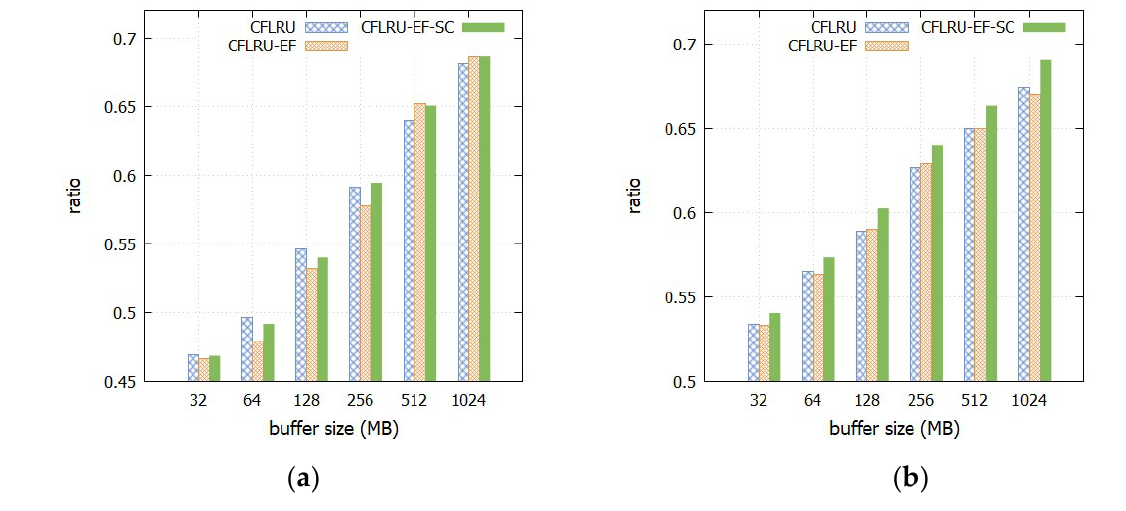
( d ) Figure 7. Cache hit ratio. ( a ) camresweba03-lvm01; ( b ) prn0; ( c ) proj0; ( d ) prxy0. 4.3. Results in an Environment with Periodic Flushing When using volatile memory, such as DRAM, as the internal buffer of an SSD, dirty buffers must be forcibly flushed to NAND upon request from the operating system or application programs. Since dirty buffers are frequently switched to clean buffers by the forced flush, the effect of early flushing is expected to decrease. In this section, we present the performance evaluation results of the CFLRU-EF-SC policy in an environment where forced flushing is performed every 30 s. Since the evaluation results between traces were similar, we present only the results for the hm0prn0proj0prxy0 trace. The results show the following. First, as shown in Figure 8a, the early flush is effec- tive in reducing the average response time even in the environment where periodic forced flushing is performed. The improvement is particularly noticeable when the cache capac- ity is small. For example, when the capacity is 32 MB, the average response time of the CFLRU-EF-SC is only 0.27 times that of the CFLRU. On the other hand, when the capacity is 1 GB, the response times of all policies are almost the same, and the effect of performing the early flush becomes insignificant. Among the early flush policies, the CFLRU-EF-SC achieves a shorter average response time than the CFLRU-EF in most cases, although the difference is not large.